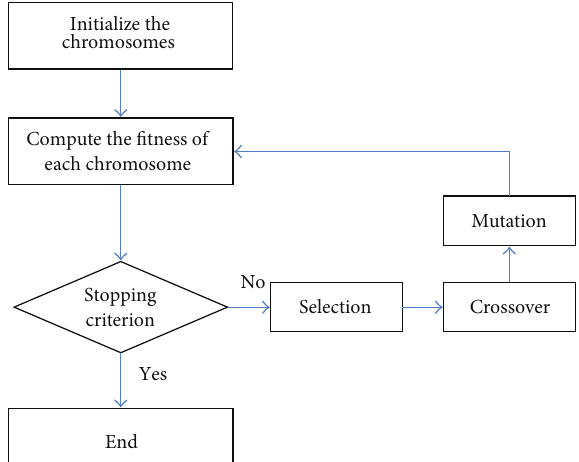
Figure 12: Block matching algorithm when there are more choices to get the global minimum.